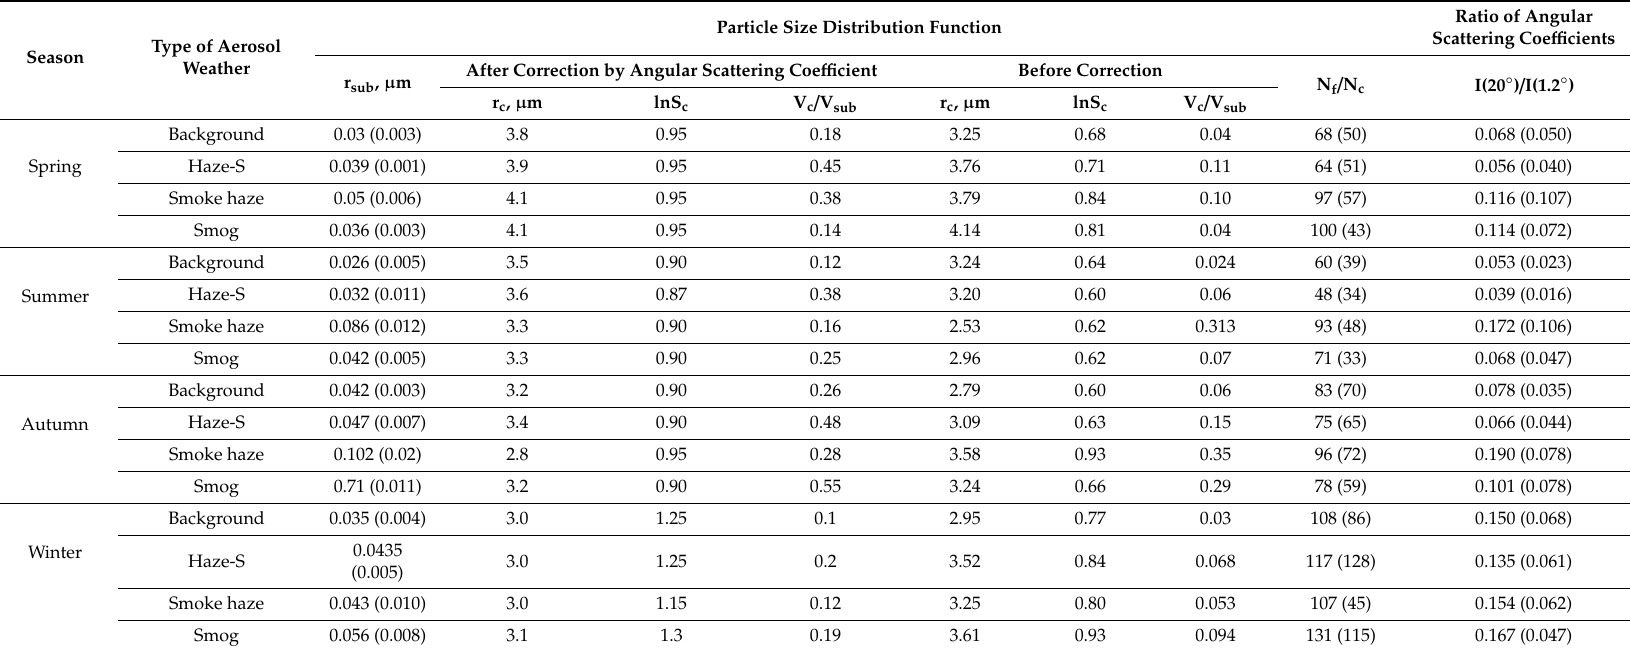
Table A1. Average values and root mean square(rms) deviations (in parentheses) of the atmospheric aerosol